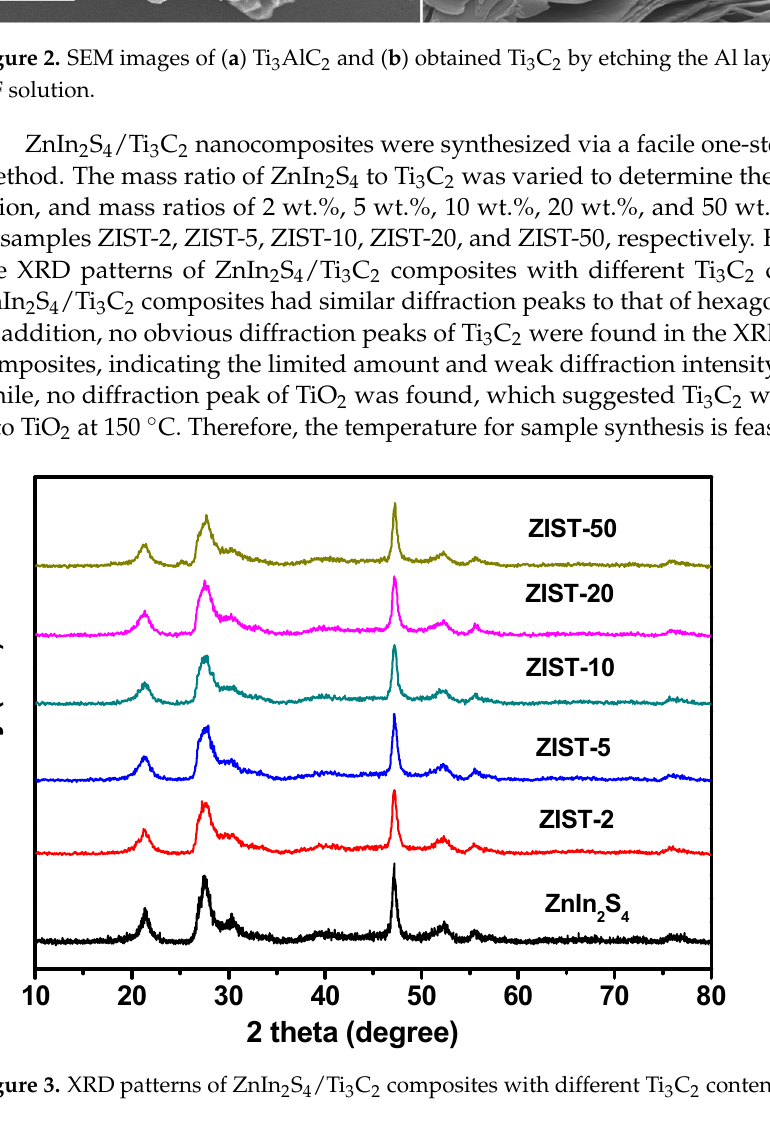
Figure 2. SEM images of ( a ) Ti 3 AlC 2 and ( b ) obtained Ti 3 C 2 by etching the Al layer of Ti 3 AlC 2 with HF solution.